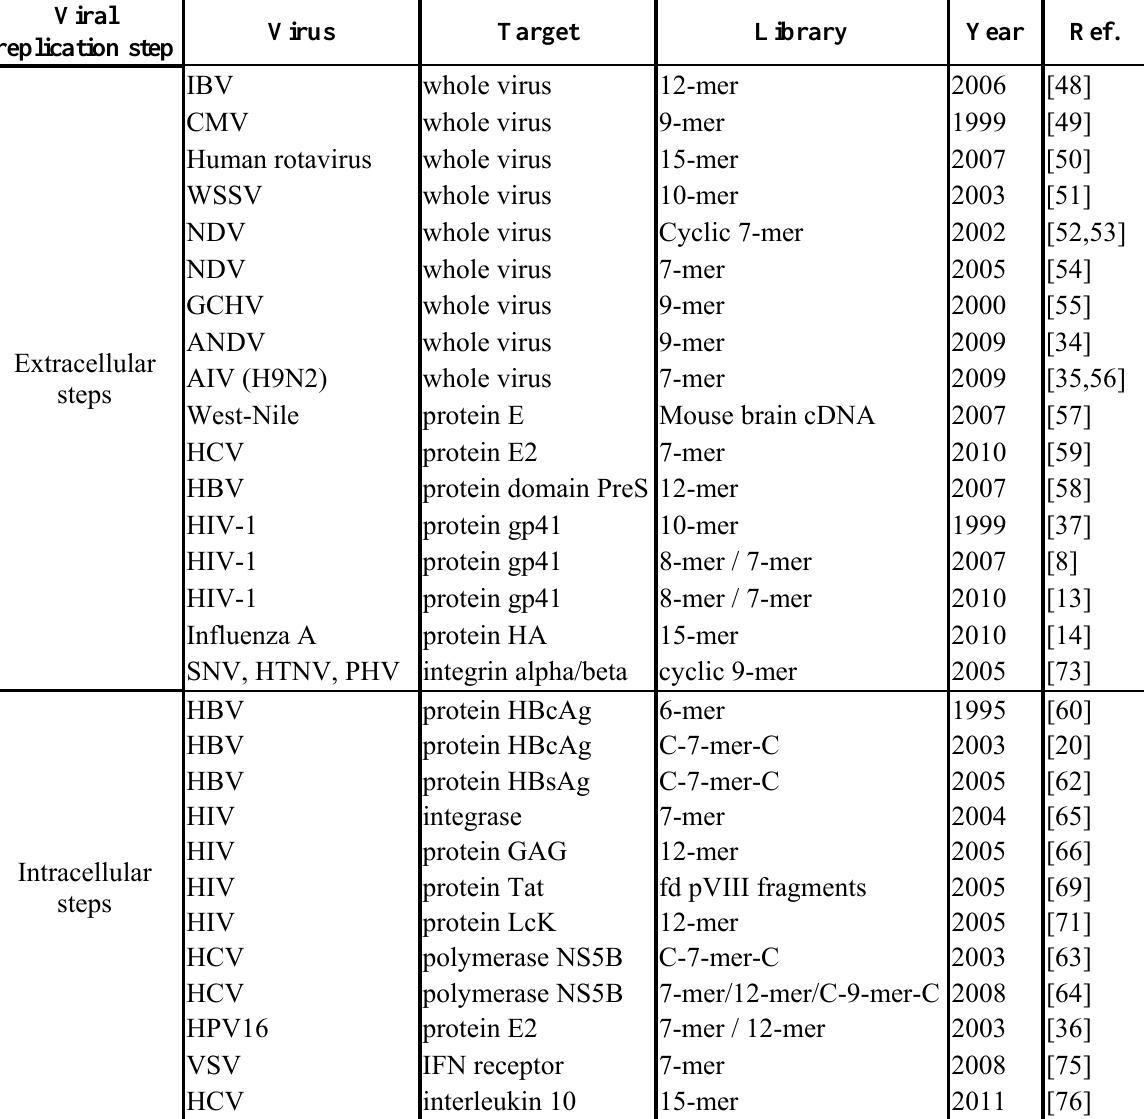
Table 1. Examples of antiviral peptides selected by phage display of combinatorial peptide libraries.